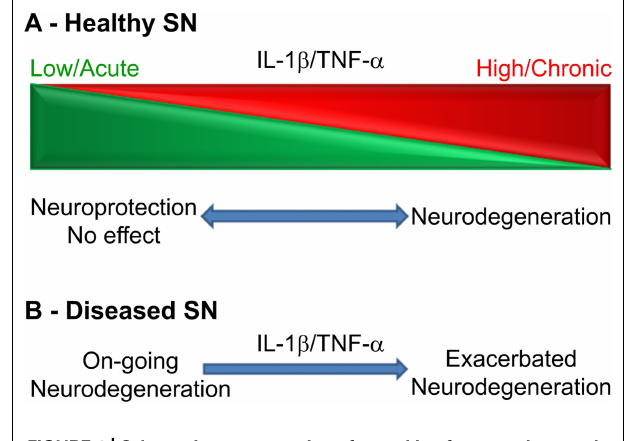
FIGURE 1 | Schematic representation of a working framework to study the functional effects of IL-1 β andTNF- α on dopaminergic neurons in vivo according to duration and levels of expression in the healthy SN (A) or in the degenerating SN (B). Clear effects are only seen at the extremes of the scheme or when a pro-inflammatory stimulus hits the already degenerating